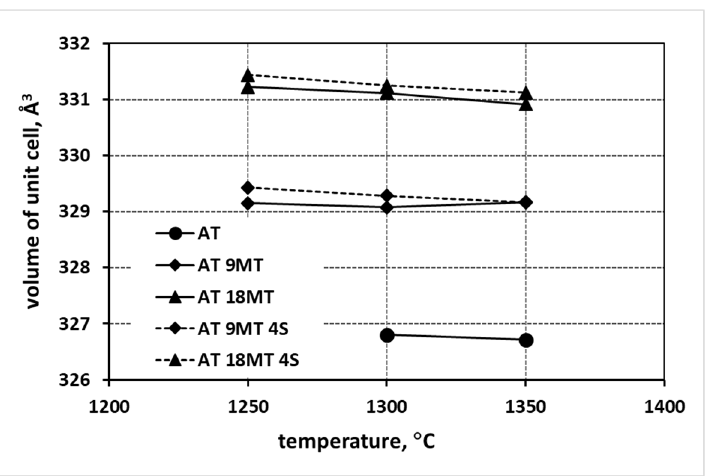
Figure 8. Changes in tialite elementary cell volume as a function of sintering temperature and stabilizing additives used (for comparison, the figure also shows the change in the unit cells of tialite AT).